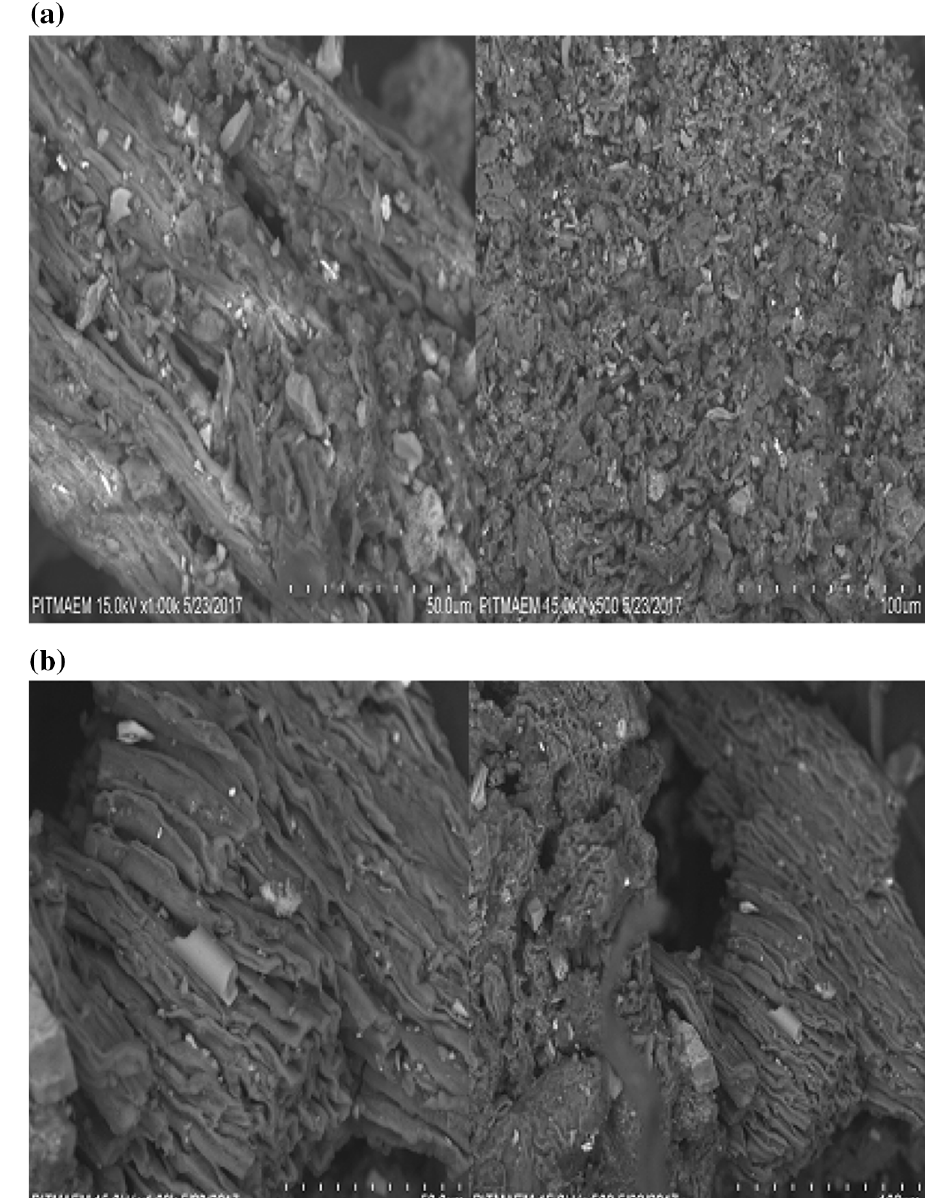
Fig. 2 a SEM spectrum of natural biosorbent at 15.0 kV 9 1.00 K